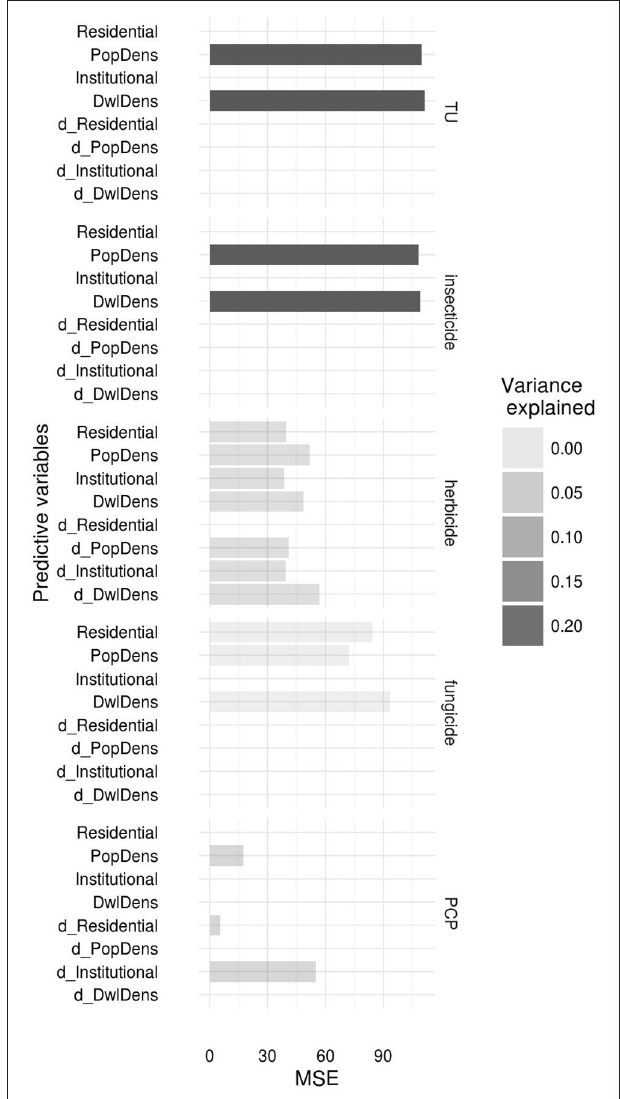
FIGURE 2 | Summary of selected predictor variables for contaminant classes and comparison of their relative influence in each model. The relative influence of each land use category is indicated on the x-axis, scaled to a percentage of the total for each model. Where a land use variable does not appear in a model, this indicates it did not contribute significantly to that model. Bars are shaded in proportion to relative goodness of fit for each